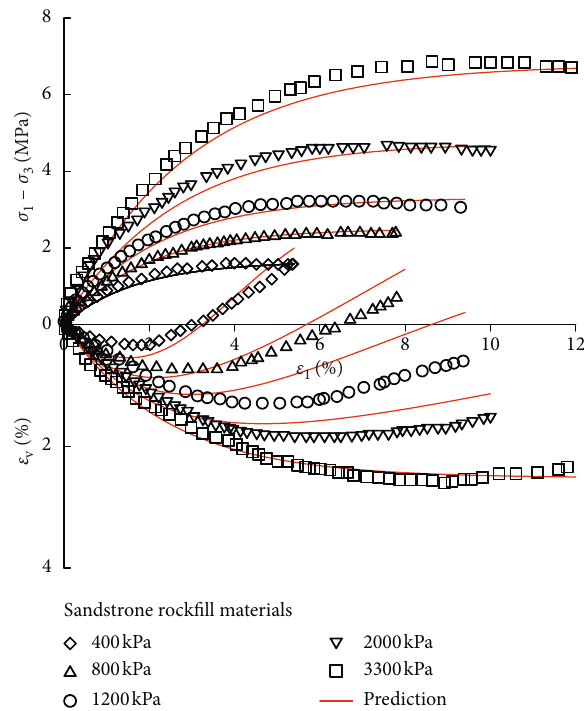
Figure 4: Sandstone rockfill materials experiment results and model prediction.